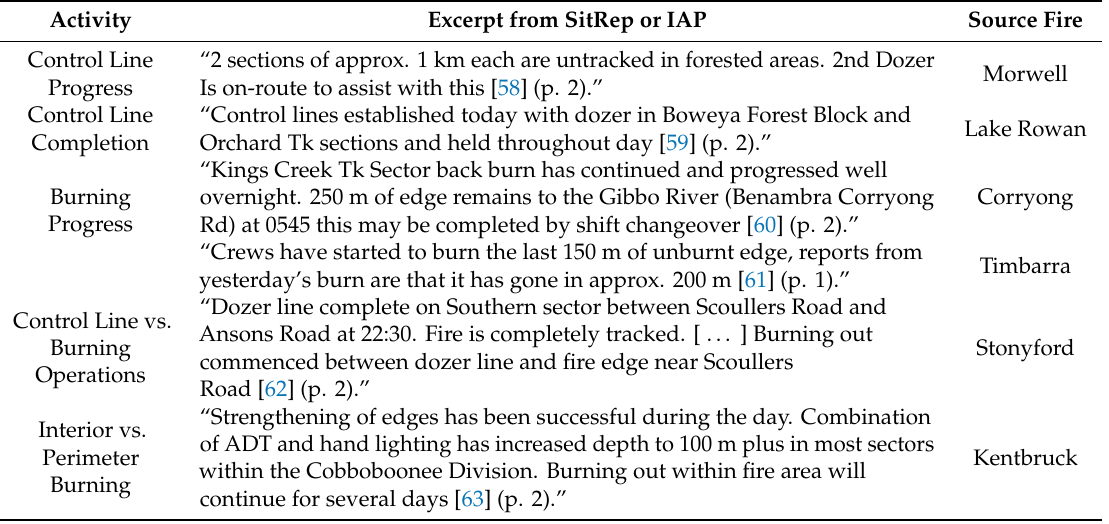
Table 5. Illustrative excerpts of the progress of control line and burning